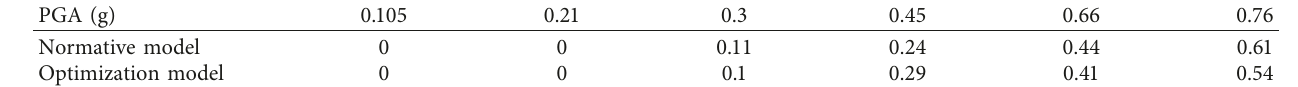
Table 13: Overall damage index value at different earthquake levels.